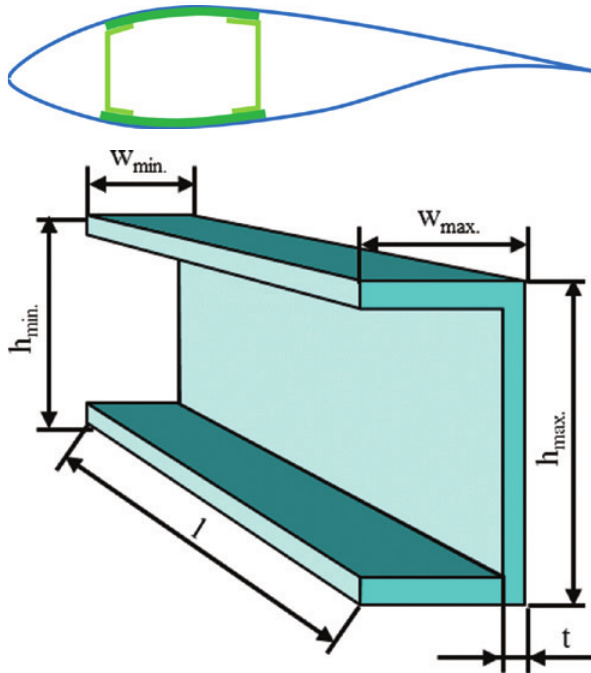
Figure 13: Inner setup of a wind turbine rotor blade (top) and geometric parameters of the spar preform (bottom).